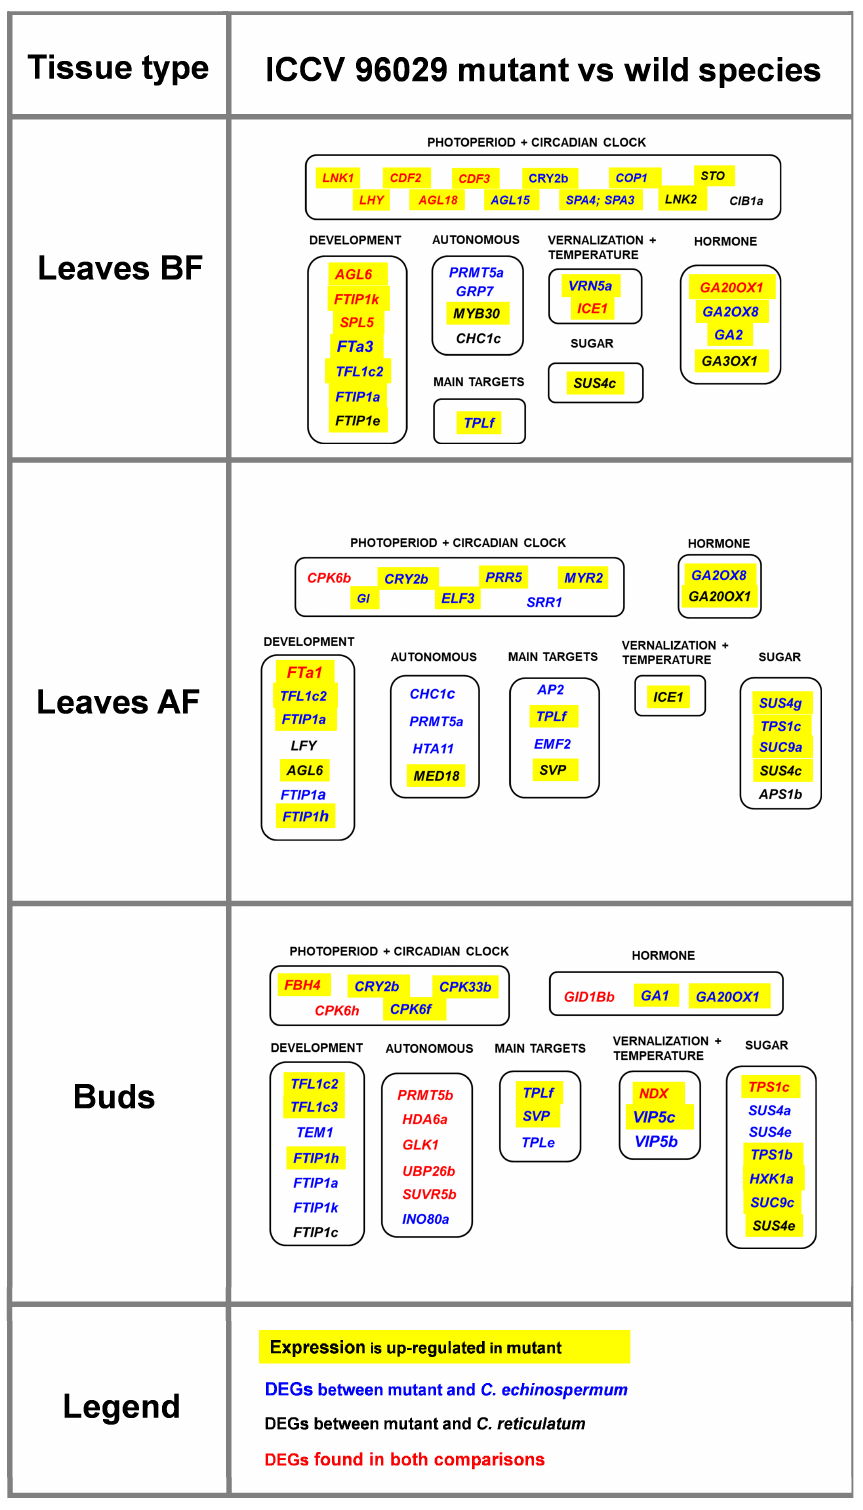
Figure A1. Flowering time genes differentially expressed between mutant ICCV 96029 and two wild species ( C. reticulatum and C. echinospermum ). Each box represents the developmental pathway (See Figure 1). Gene upregulation in a particular species/accession is shown by yellow shading of the gene name. Different comparisons are indicated by text color (see legend at the bottom of the